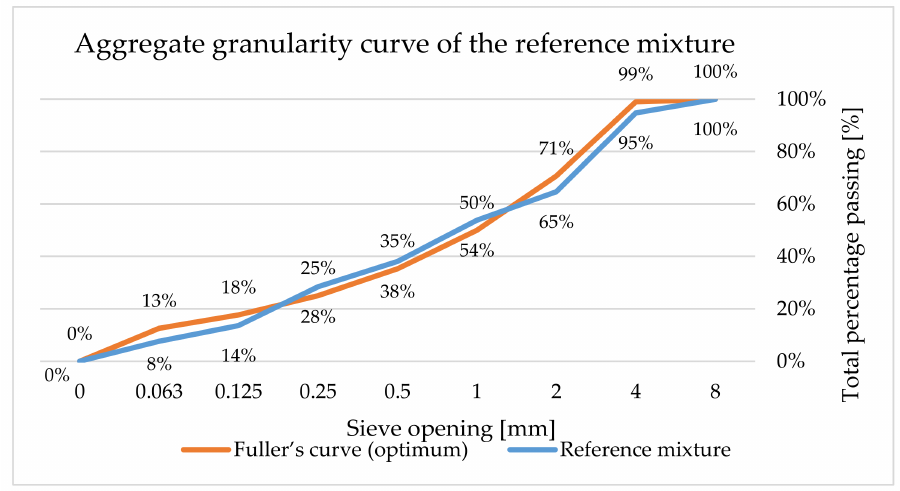
Figure 4. Granularity curve in the reference